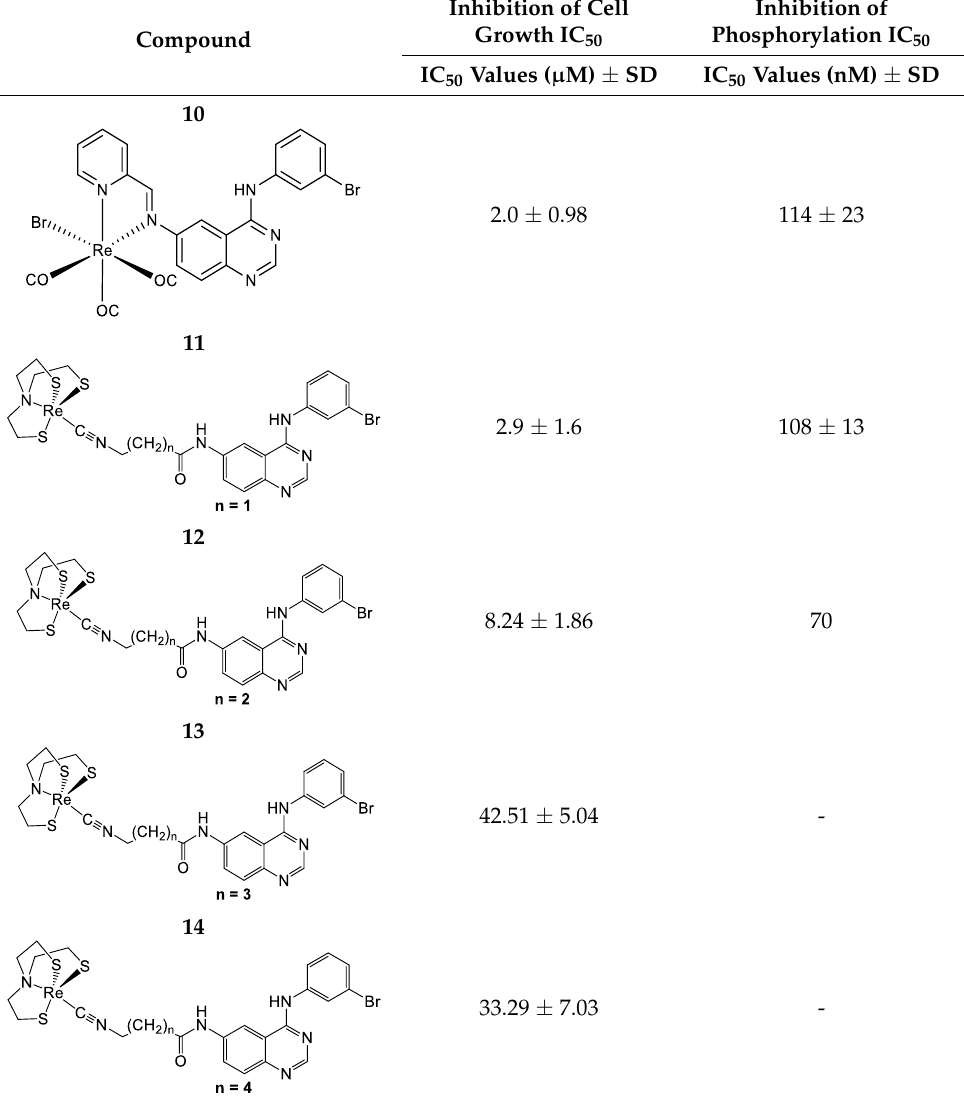
Complex 5a was evaluated for its potency to inhibit EGFR phosphorylation in various concentrations by immunoblotting in intact A431 cells that overexpress EGFR (Figure 3). In addition, the percentage of EGFR phosphorylation was calculated, and a dose-response curve was performed (Figure 4). The IC 50 value of the complex indicating the concentration (nM) needed to inhibit phosphorylation by 50% was 26.11